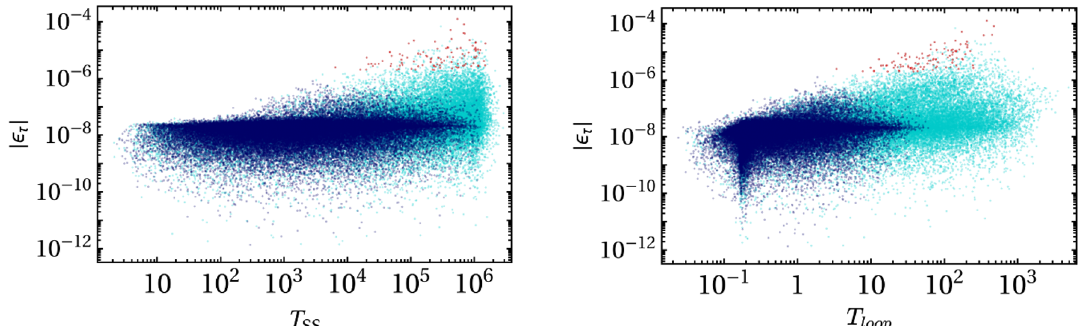
Figure 7 . Scatter plots of j (cid:15) (cid:28) j against the (cid:12)ne-tuning in the seesaw measured by T SS in (5.4) (left) and the relative one-loop contribution in T loop in (5.9) (right) for the CP (cid:22)(cid:28) symmetric model assuming M 1 = 10 9 GeV. Light blue and dark blue indicate di(cid:11)erent allowed ranges for parameters in the Casas-Ibarra paremetrization. See text for details and also appendix